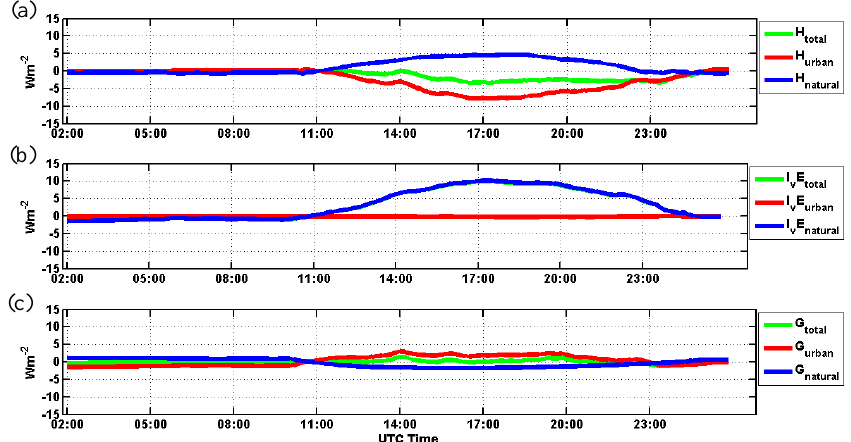
Fig. 10. Change of flux (case 10s – case 20s) for sensible heat flux (a) , latent heat flux (b) and ground heat flux (c) including the total (green) urban (red) and natural surface (blue) contributions to each. Change shown is averaged over all grid cells in the fourth model grid of the domain, plotted versus time (UTC) for the Period 02Z 24 June – 02Z 25 June 2007 in units of Wm − 2